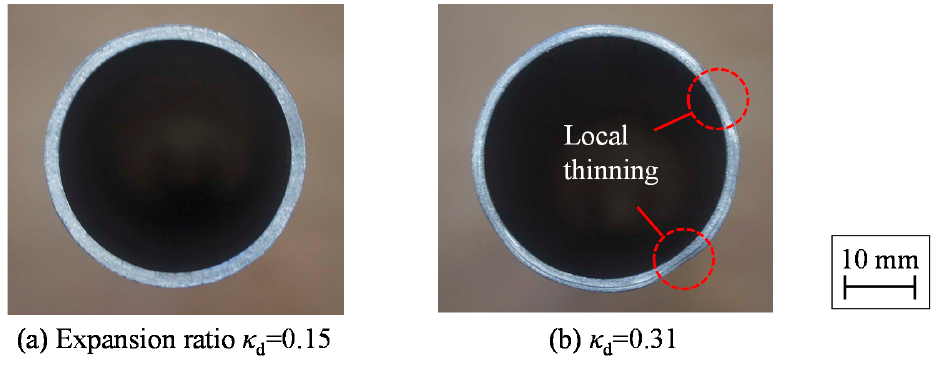
Figure 18. Distribution of thickness change ratio η in hoop direction by drawing process.